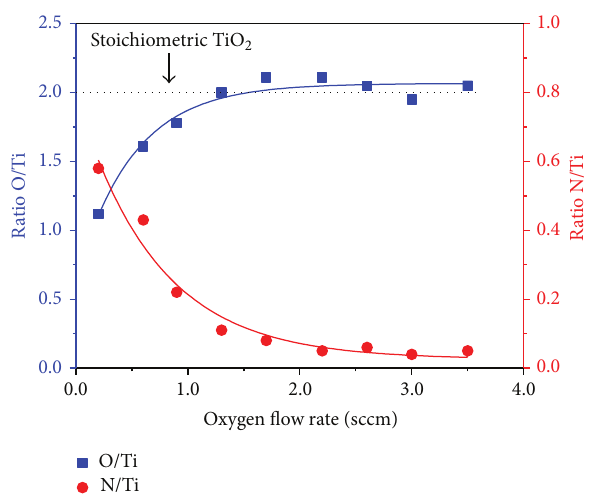
Figure 6: Chemical composition of the films obtained by RBS as function of the oxygen flow rate (reproduced from [32]).